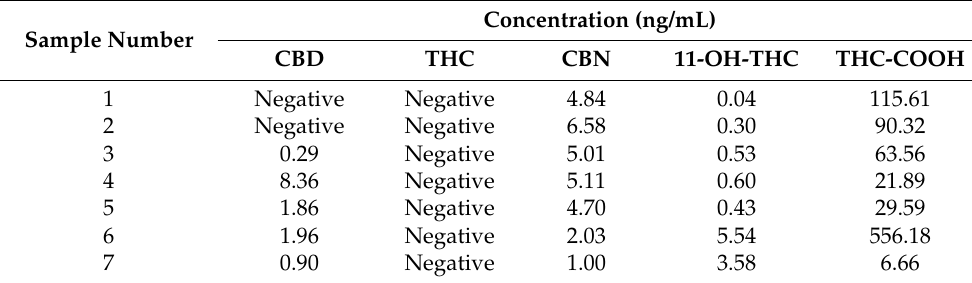
Table 6. Concentrations of cannabinoids found in authentic urine